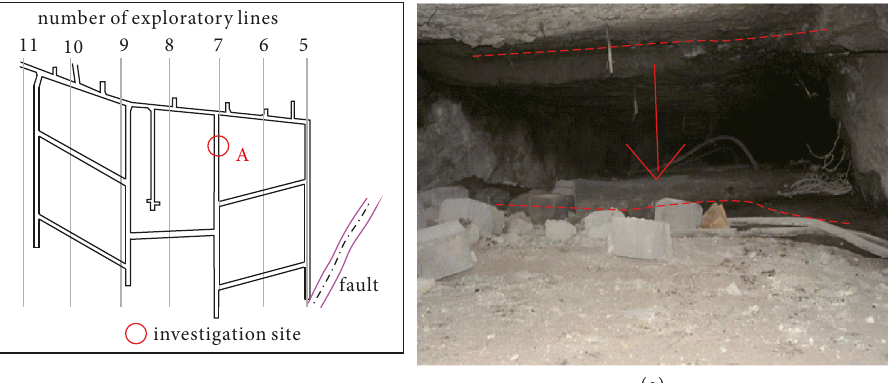
Figure 6: The location of the investigation and the filed destructions at the 1630m